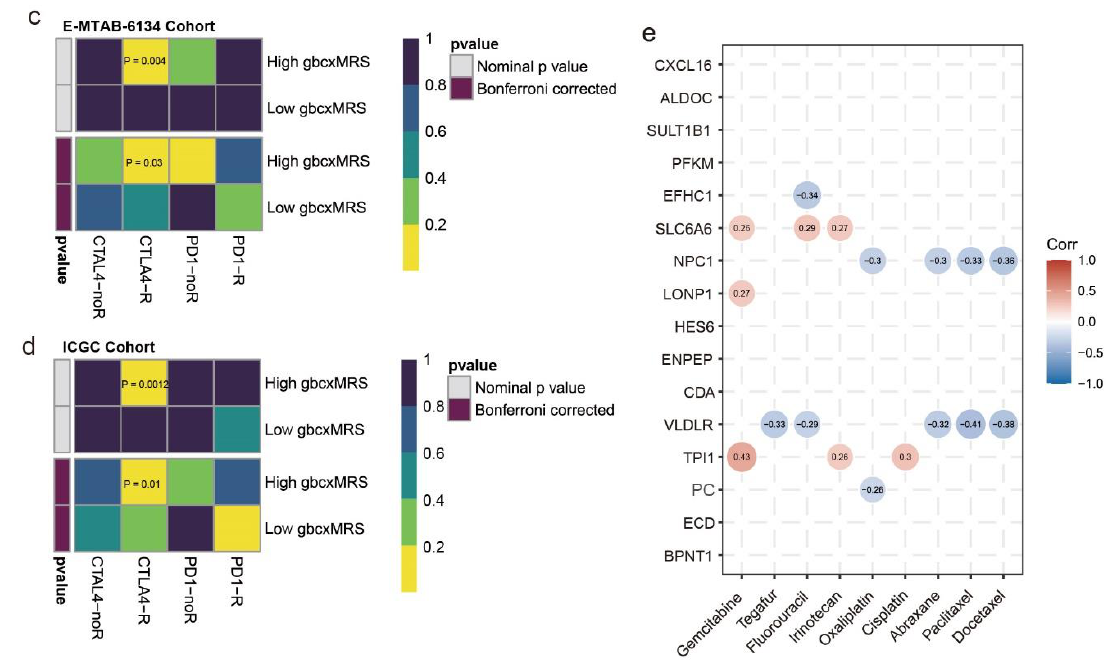
Figure 8. GbcxMRS predicted drug sensitivity in PDAC. ( a , b ) The estimated drug sensitivity (log AUC) for 5-fluorouracil, irinotecan, and docetaxel between the high and low gbcxMRS groups in the ( a ) E-MTAB-6134 and ( b ) ICGC cohorts. ( c , d ) Submap analysis indicated that the high gbcxMRS group could be more sensitive to CTLA-4 inhibitors in both the ( c ) E-MTAB-6134 and ( d ) ICGC cohorts. ( e ) Sixteen genes were related to the sensitivity of multiple chemotherapy drugs in a pan-cancer analysis using the CellMiner database (27 April 2021). *, **, and *** represent significant at the levels p ≤ 0.05, p ≤ 0.01, and p ≤